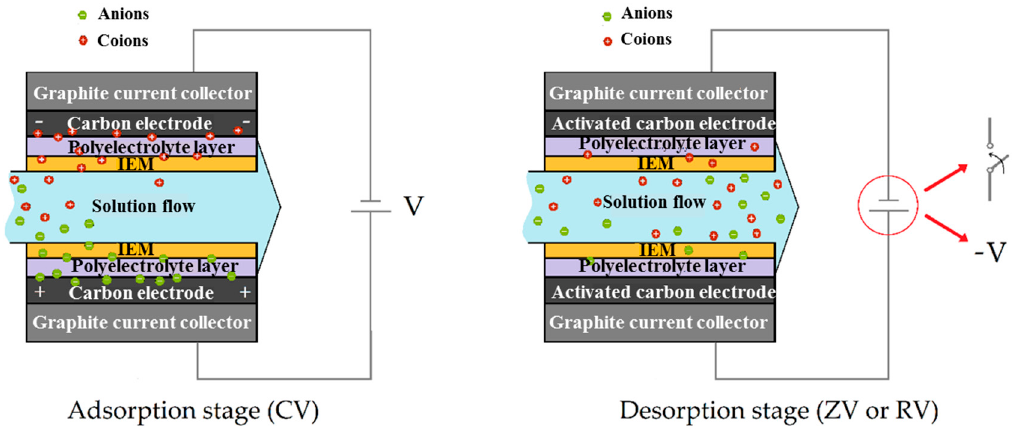
Figure 2. Schematic representation of adsorption step ( left ) by connecting a constant voltage (CV) power source. The desorption stage ( right ) proceeds by either short-circuiting the system (ZV—zero voltage) or applying the opposite potential difference (RV—reverse voltage).